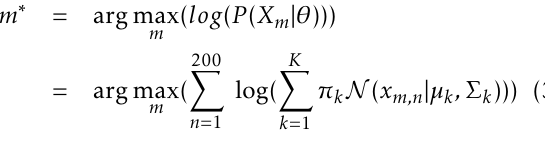
Our criterion is the maximum log-likelihood of the gesture given the DPGMM